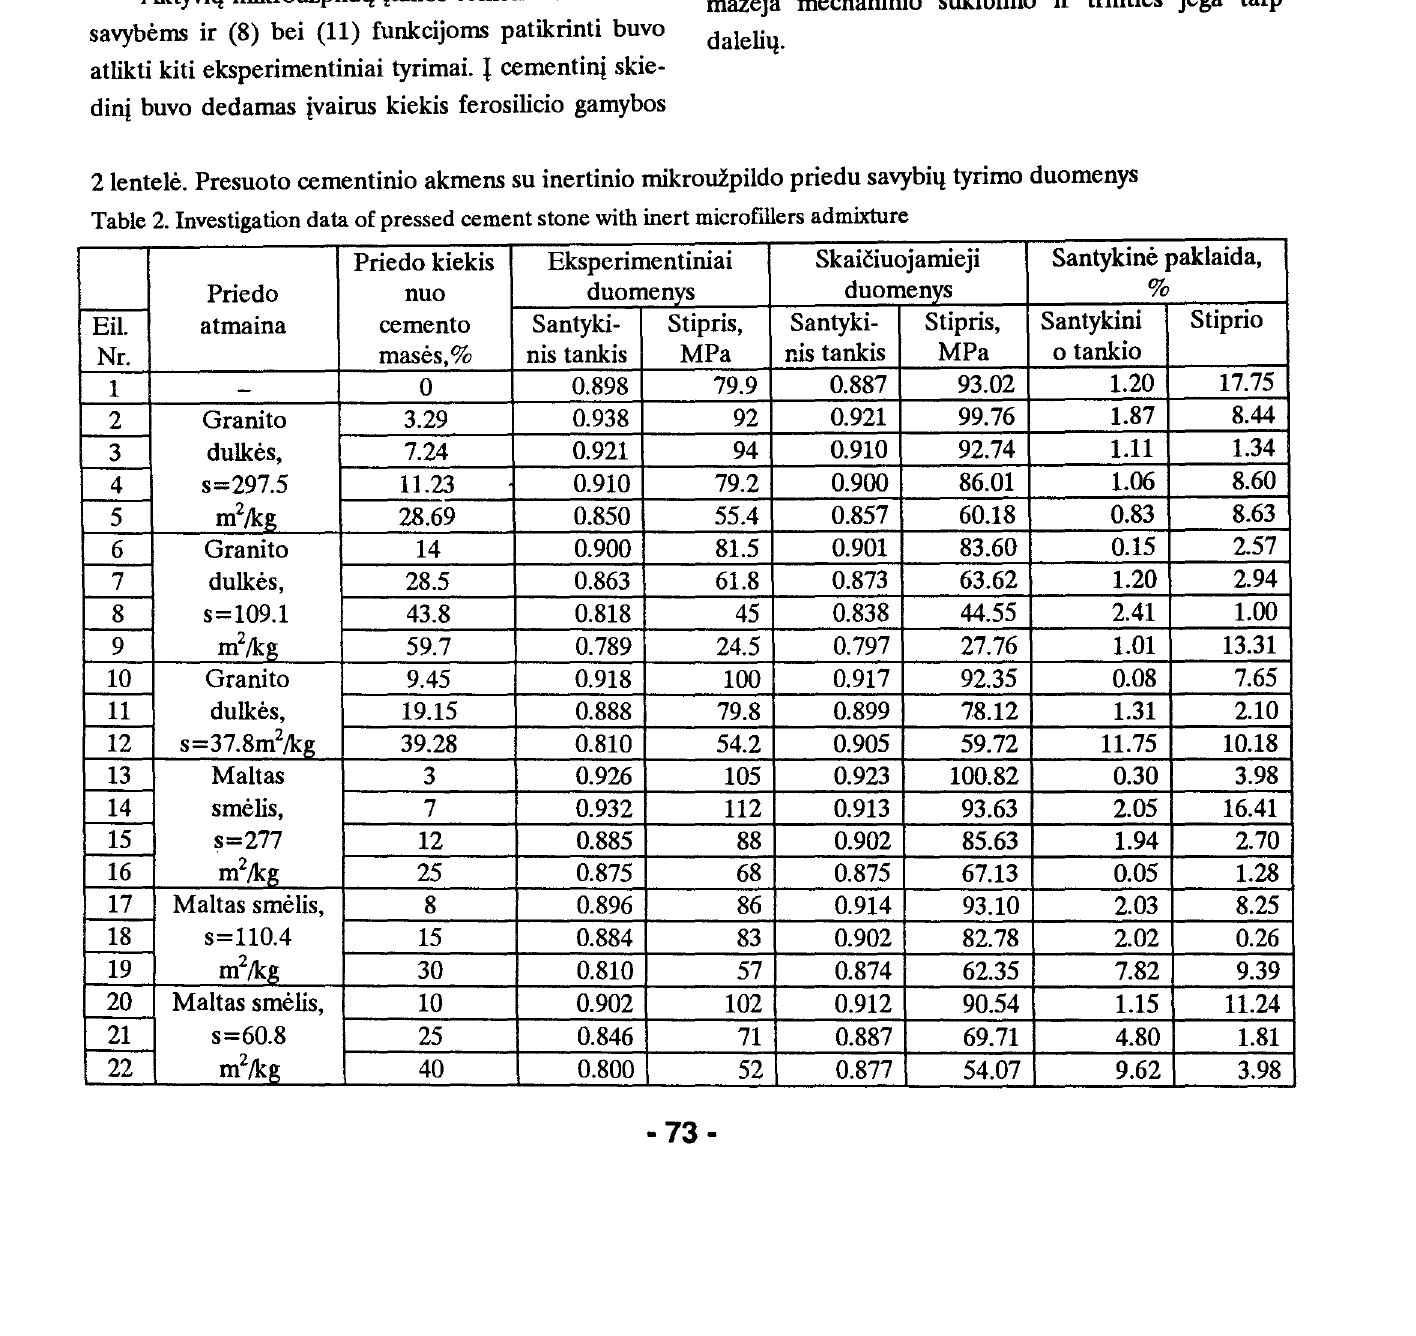
Table 2. Investigation data of pressed cement stone with inert microfillers